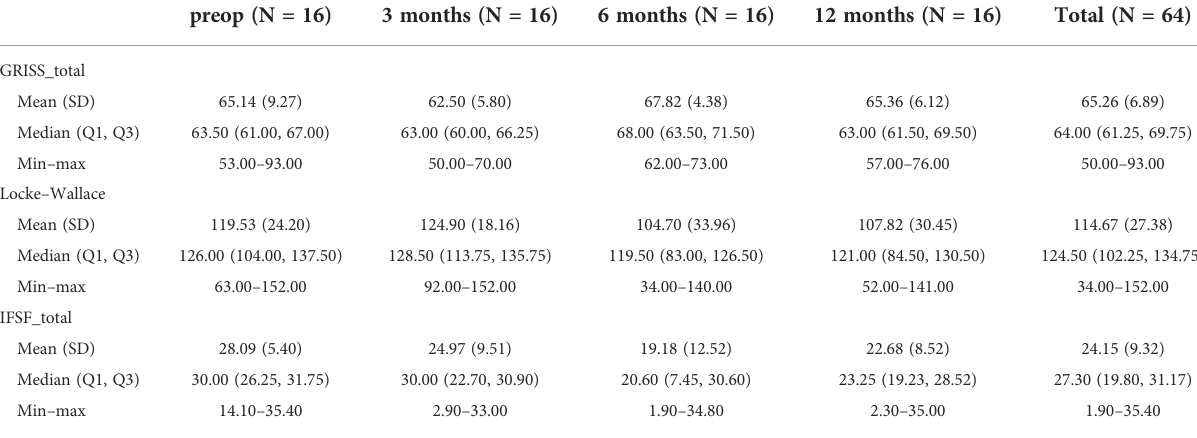
TABLE 3 Summary outcomes for women.